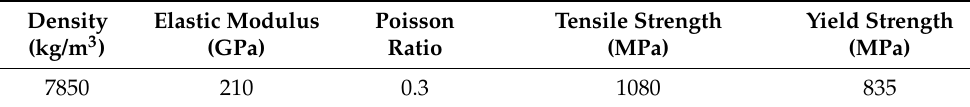
Table 4. The mechanical properties of 35CrMo.